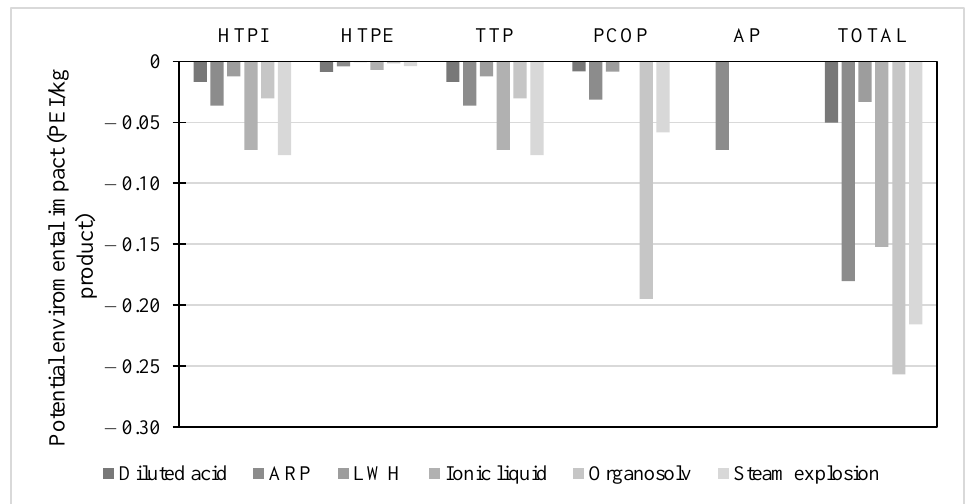
Figure 3. Potential environmental impact of pretreatment schemes for hemicellulose isolation. The potential environmental impact generated by the pretreatment schemes for the isolation of the lignin fraction is shown in Figure 4. Similar to the pretreatments for cellulose isolation and hemicellulose removal, the schemes used for lignin fractionation did not express any harmful environmental impact, except for the RAAE pretreatment concerning human toxicity. The RAAE pretreatment is the only pretreatment that shows harmful environmental impacts for pretreatments focused on cellulose and lignin